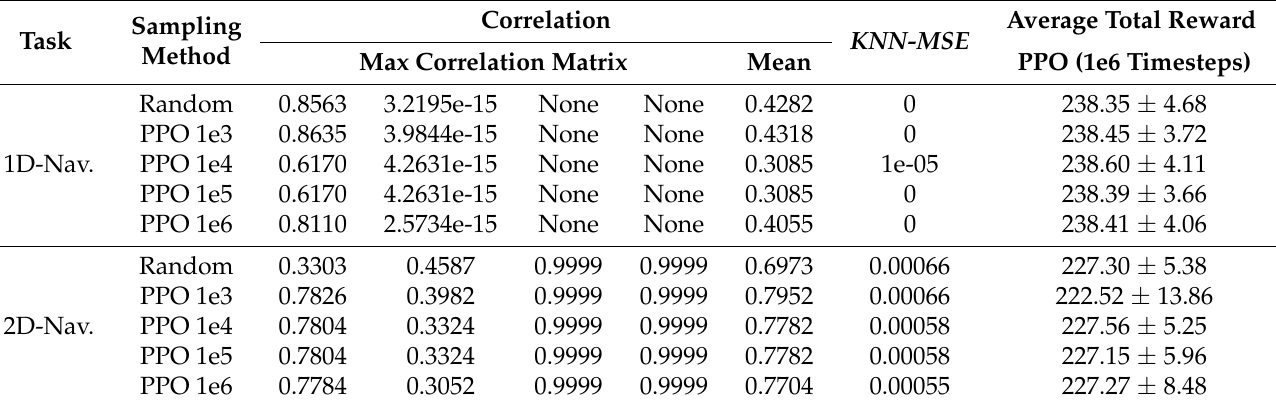
Table 5. The influence of sample quality in mobile robot